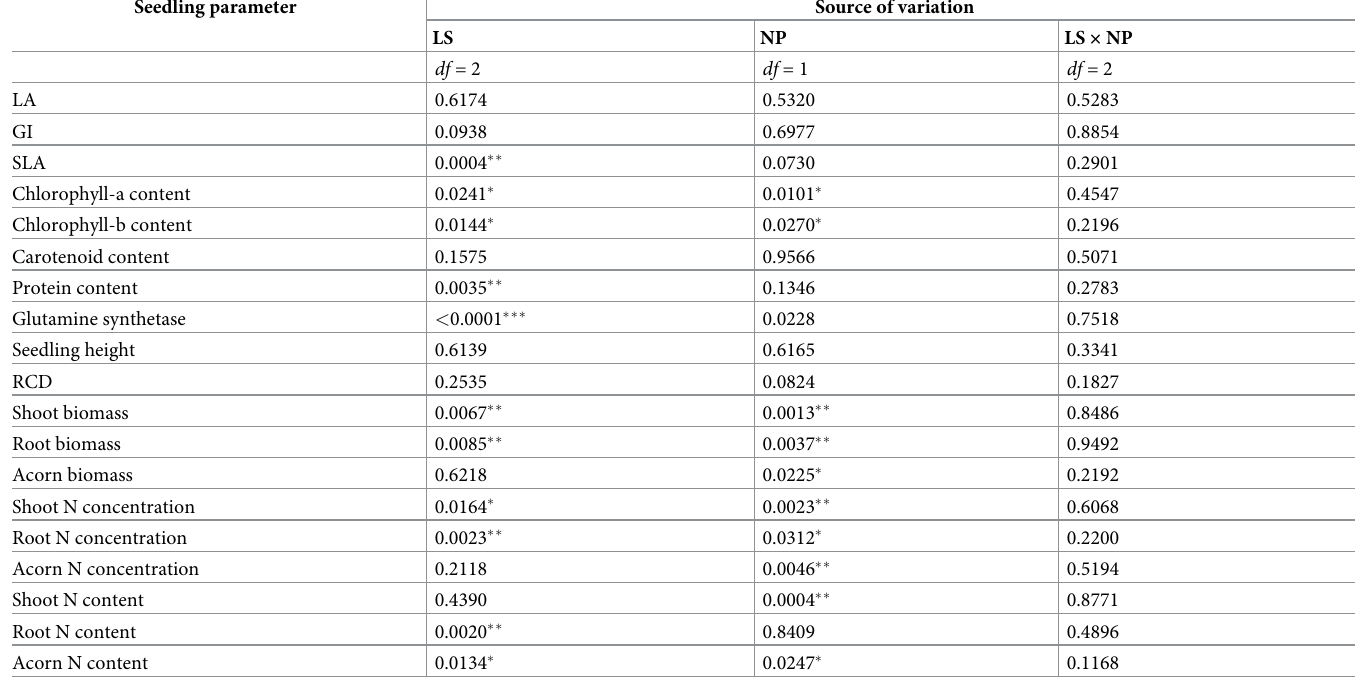
Table 2. P -values from analysis of variance (ANOVA) of lighting spectrum (LS), 15 N pulse (NP), and their interaction (LS × NP) on growth and foliar physiology in Chinese cork oak ( Quercus variabilis Blume) seedlings. Seedling